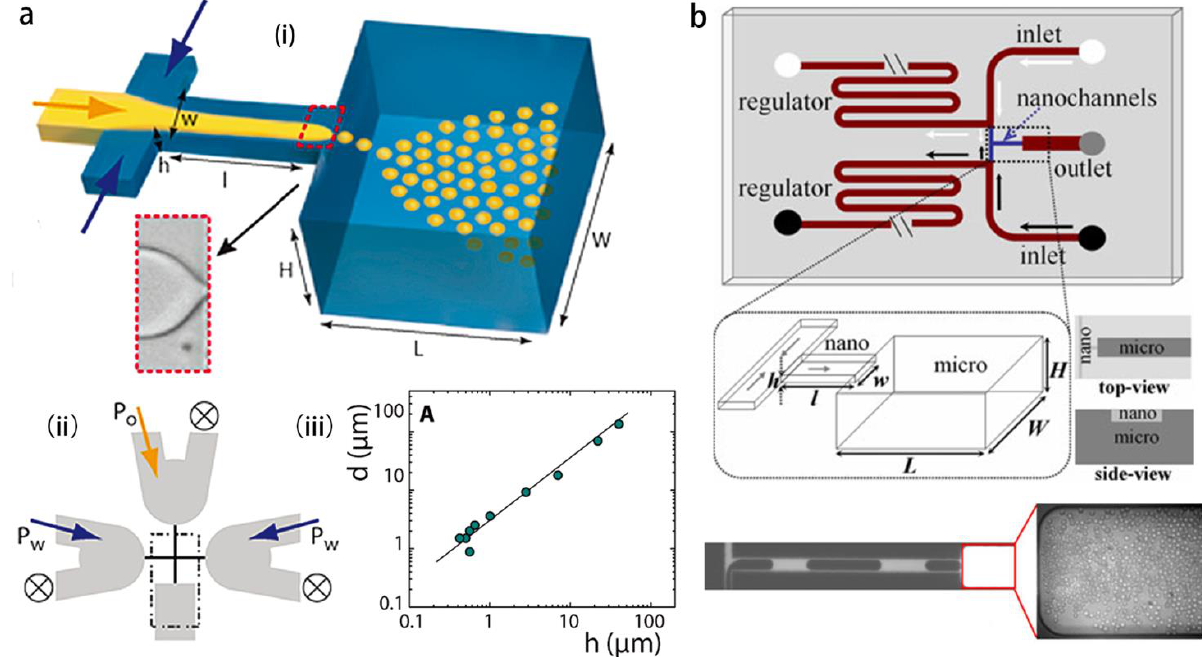
Figure 9. Co-flow step-emulsification method that generates micron and submicron droplets by downsizing the channel depth. ( a ) Device with shallow channel connected with a wide and deep reservoir ( i ), wide and deep “river” channels that prevent clogging at nanochannel ( ii ), and droplet diameter vs. channel depth ( iii ). Reproduced from [98], copyright 2010, American Chemical Society. ( b ) Submicron droplets formed in the step-emulsification nano-device, reproduced from [99], copyright 2011, Springer.